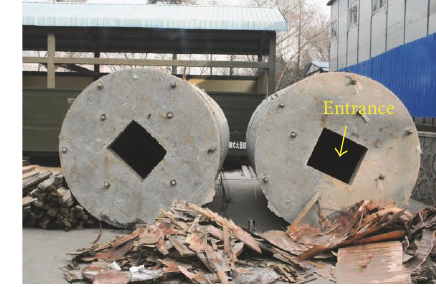
Figure 2: Test models.